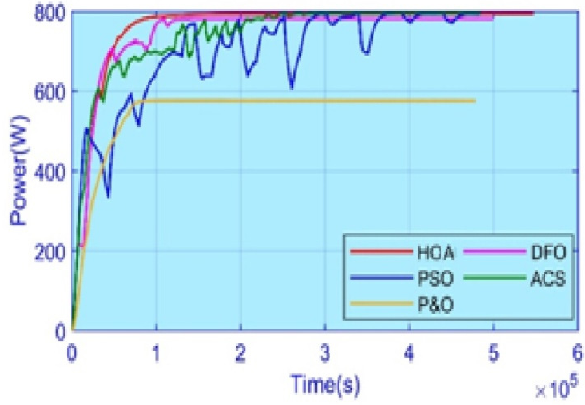
Figure 19. Comparison of the HOA power for Case